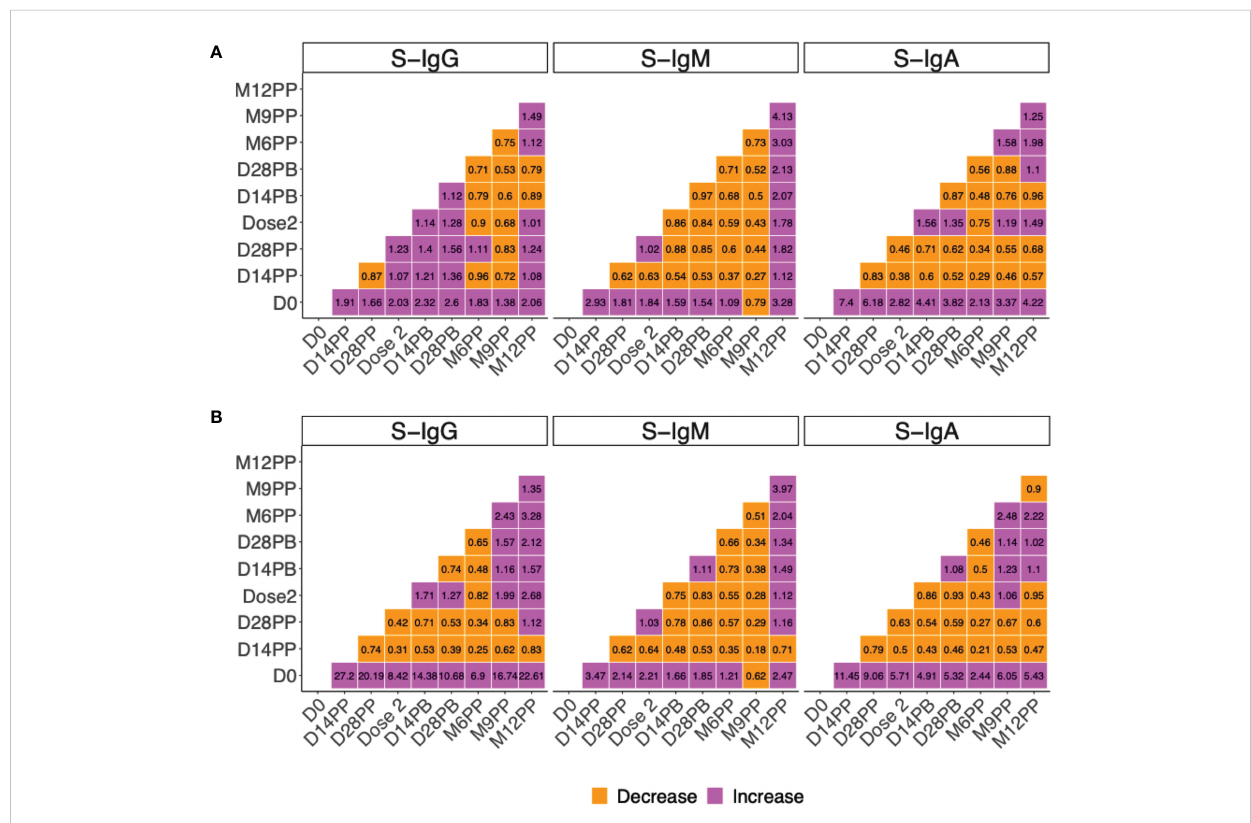
FIGURE 6 Median fold change in in spike-directed antibody levels over time. Figure 6 summarises the fold change in spike-directed IgG, IgM and IgA antibody OD values (A) and concentrations (B) across the different specimen collection time points. The heat map shows the extent of change (increase or decrease) in vaccine-induced antibody response over time. The change between time points is shown with each cell indicating an increase or decrease between any two timepoints at the x and y axis. Fold change between 0 to 1 indicate a decrease (orange), Fold change of 1 indicates no change while fold change greater than 1 indicate an increase